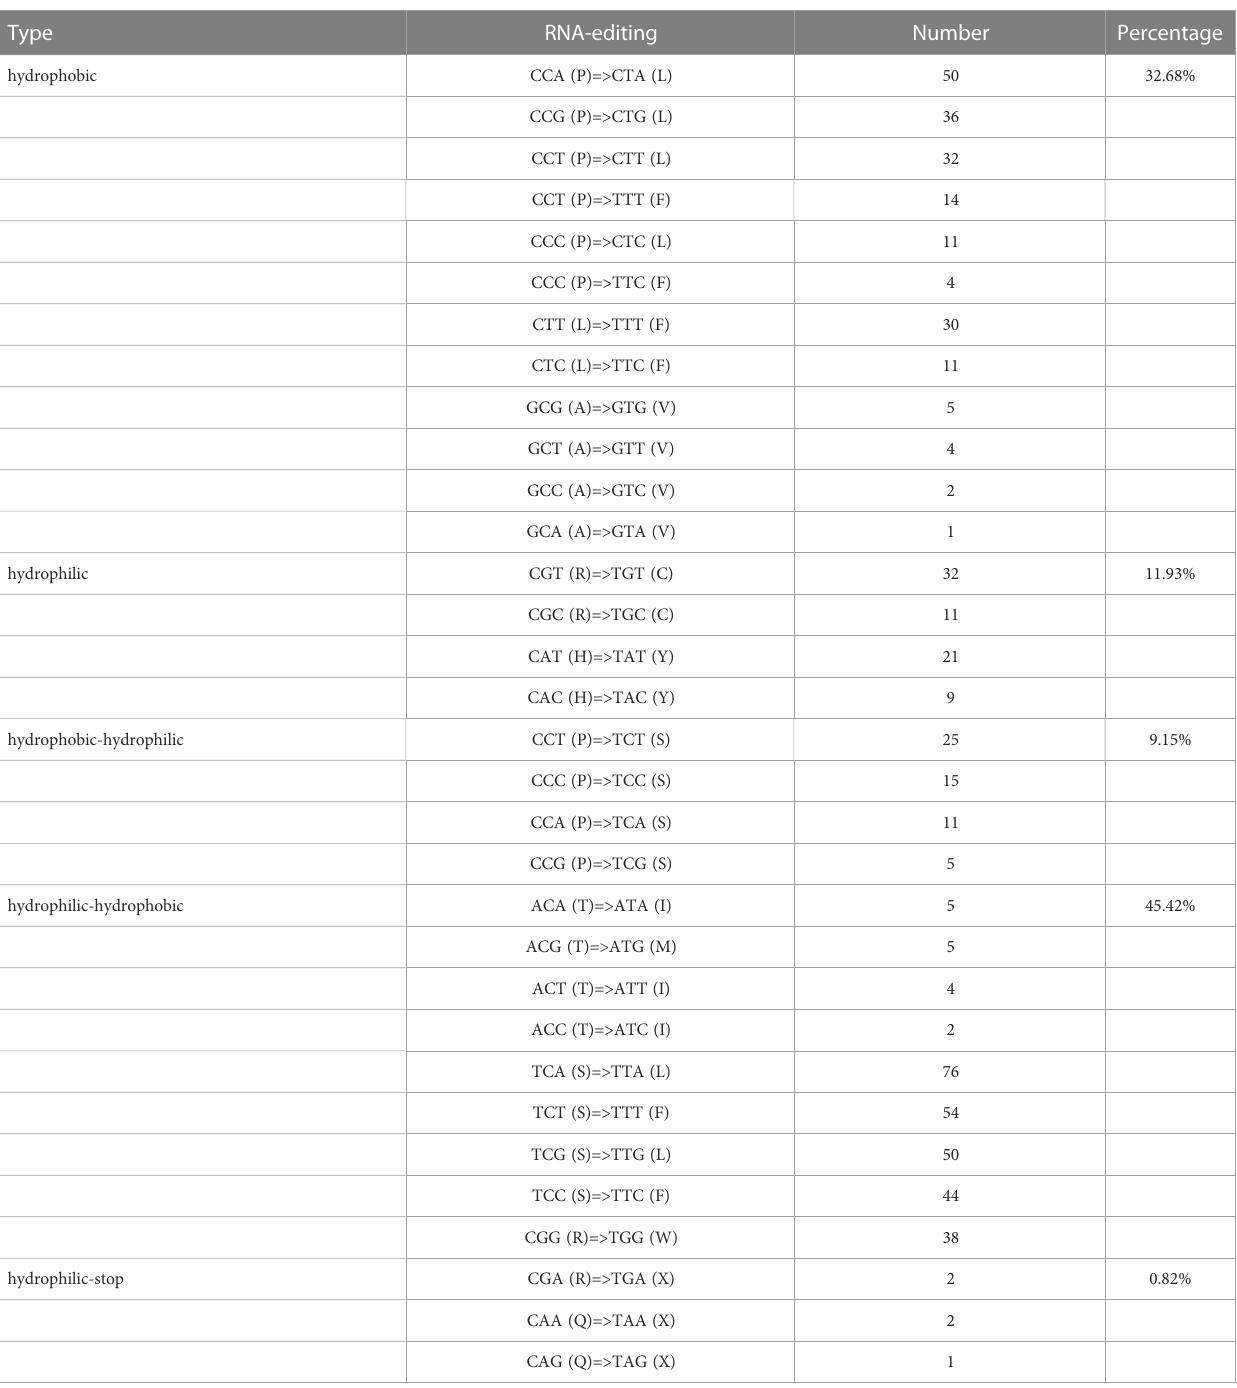
TABLE 4 Characteristics of hydrophilic and hydrophobic changes in RNA editing